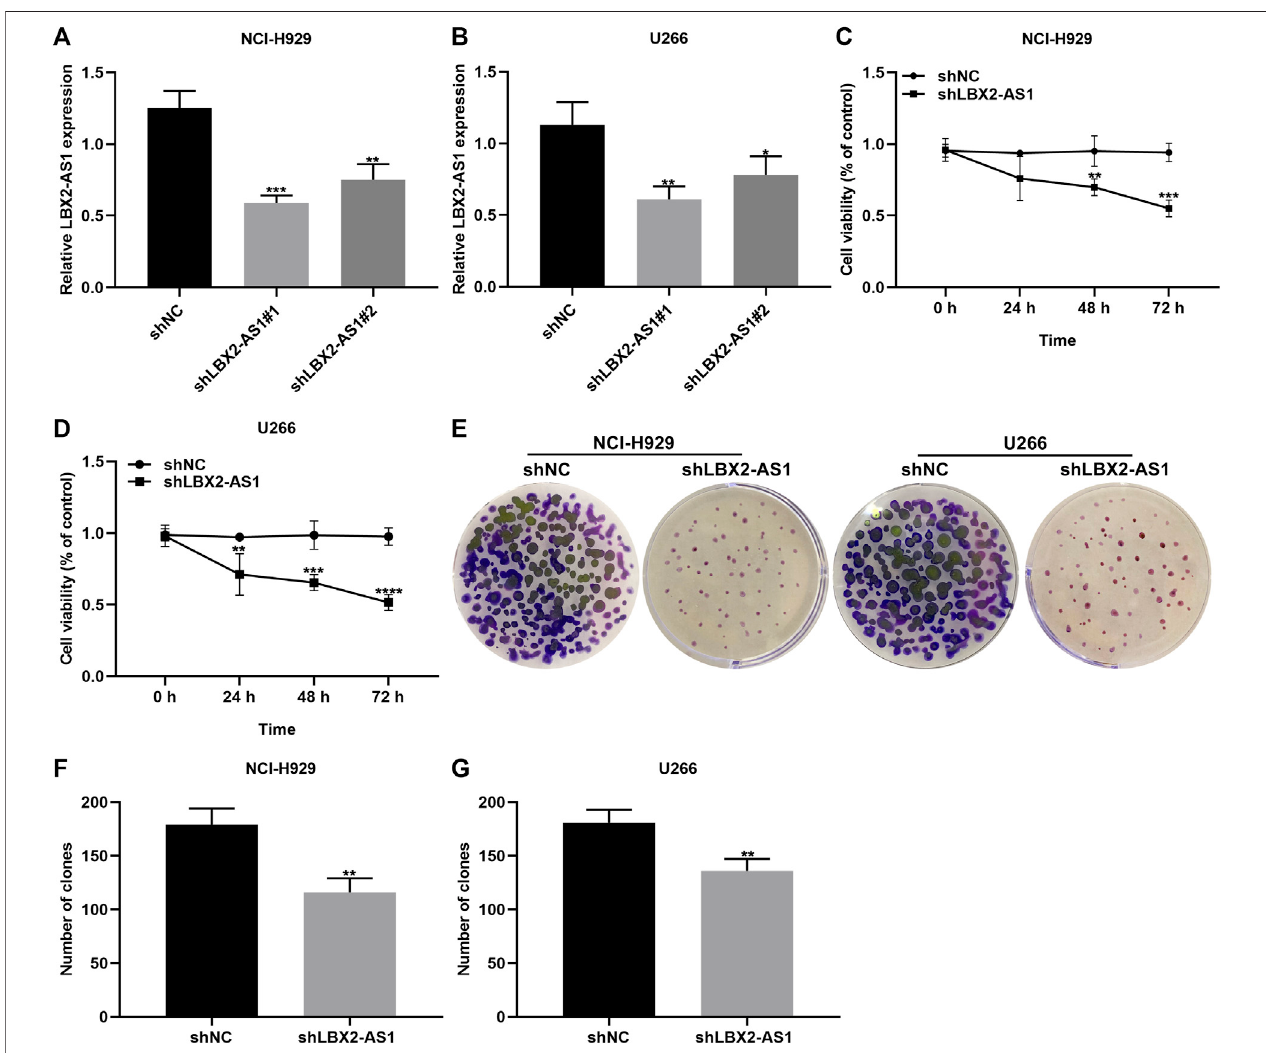
FIGURE 2 | Knockdown of LBX2-AS1 suppresses proliferative ability of MM cells. (A, B) Detection of LBX2-AS1 expression in NCI-H929 and U266 cells transfected with shNC, shLBX2-AS1#1 or shLBX2-AS1#2 by RT-qPCR. (C, D) Assessment of the cell viability of MM cells with shNC or shLBX2-AS1 at 0, 24, 48, and 72 h by CCK-8 assay. (E – G) The number of clones for MM cells transfected with shNC or shLBX2-AS1. * p < 0.05; ** p < 0.01; *** p < 0.001; **** p <